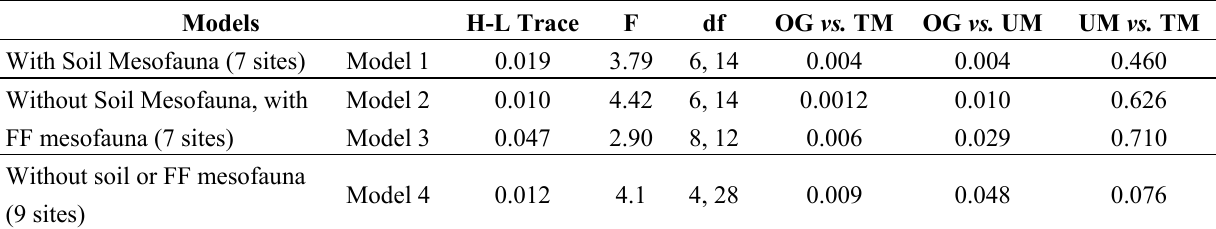
Table 5. Significant multivariate models of stand type differences. AMN = anaerobic mineralizable nitrogen; FF = forest floor; H-L Trace = Hotelling-Lawley Trace. Models H-L Trace F df OG vs. TM OG vs. UM UM vs. TM Model 1